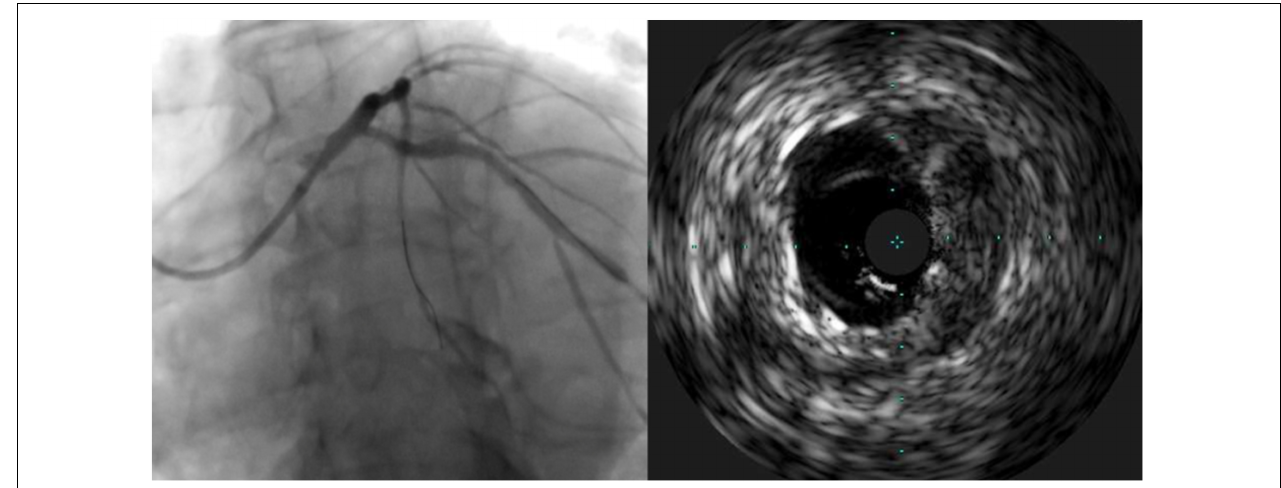
FIGURE 2 | Case of geographic miss showing incomplete ostial coverage by angiography and intravascular ultrasound.